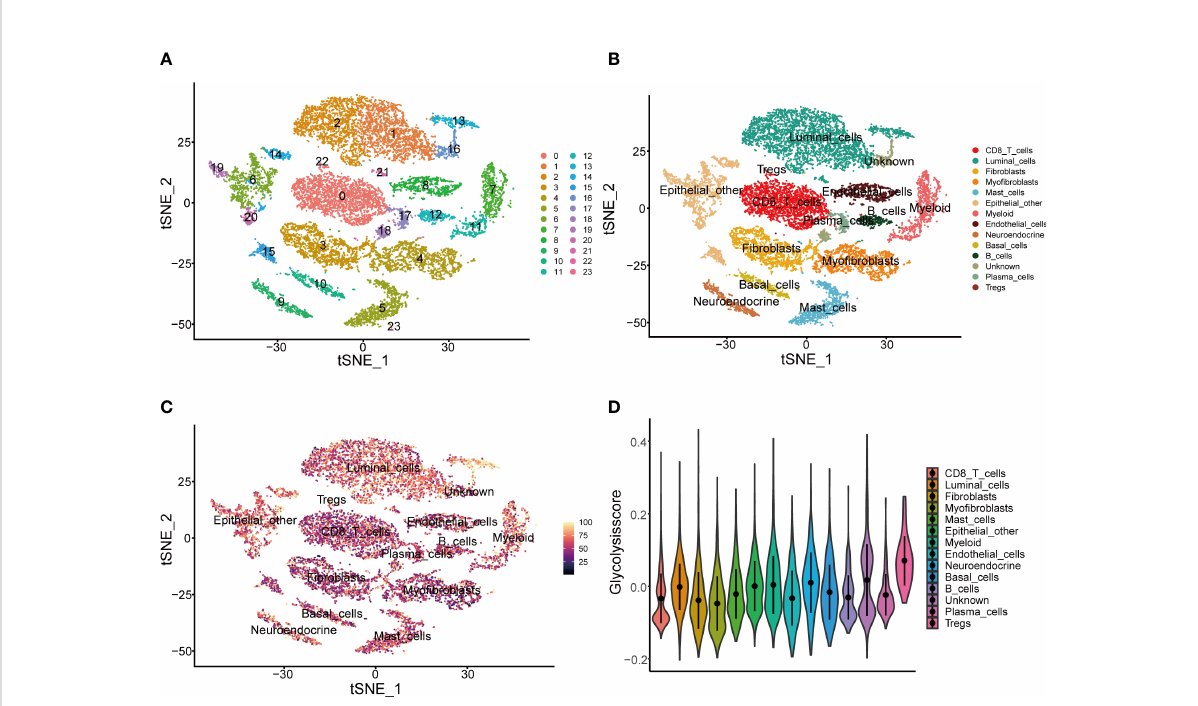
FIGURE 6 Presentation of Glycolysis Score at the single-cell level. (A, B) Single-cell analysis based on GSE137829. (C) t-SNE plot of single cells colored by the Glycolysis Score. (D) The comparison of Glycolysis Score among different cell